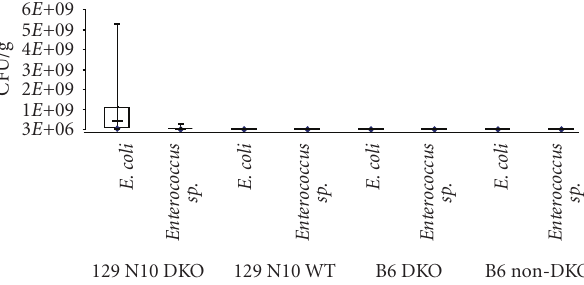
Figure 9: Box and whisker plots of the levels of cecal E. coli (large colonies on LB plates under aerobic conditions) and Enterococcus sp . (small colonies on LB plates; E. faecalis, E. hirae, or E. gallinarum ) for mice on AIN diet. Bacteria counts are based on colony forming units per gram of cecal contents (CFU/g) at 24 hours, 37 ◦ C. Representative colonies were stabbed with a micropipet tip and transferred to ARISA PCR mix. The PCR products were resolved on agarose gels for comparison to laboratory E. coli and the PCR products were further isolated and sequenced for final identification of